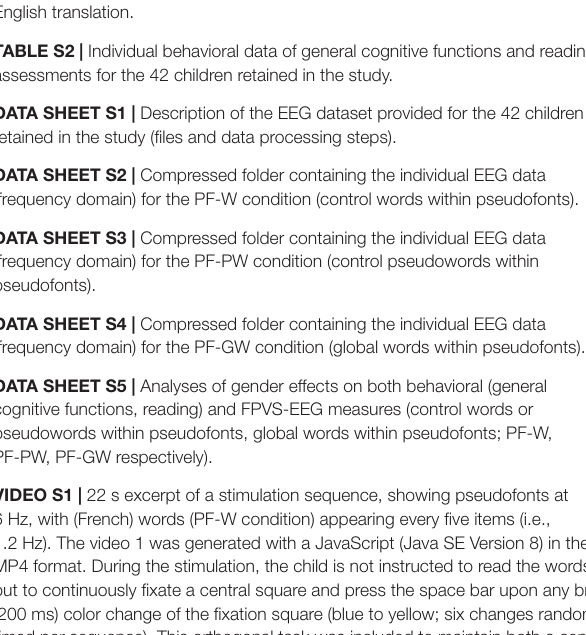
TABLE S1 | Complete list of target stimuli used in the FPVS-EEG testing (global words, control words and control pseudowords) in French as well as in their English